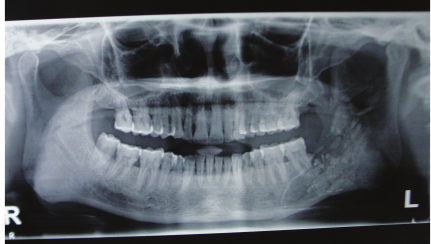
Figure 11: Orthopantomogram of the jaws three weeks after the injury.